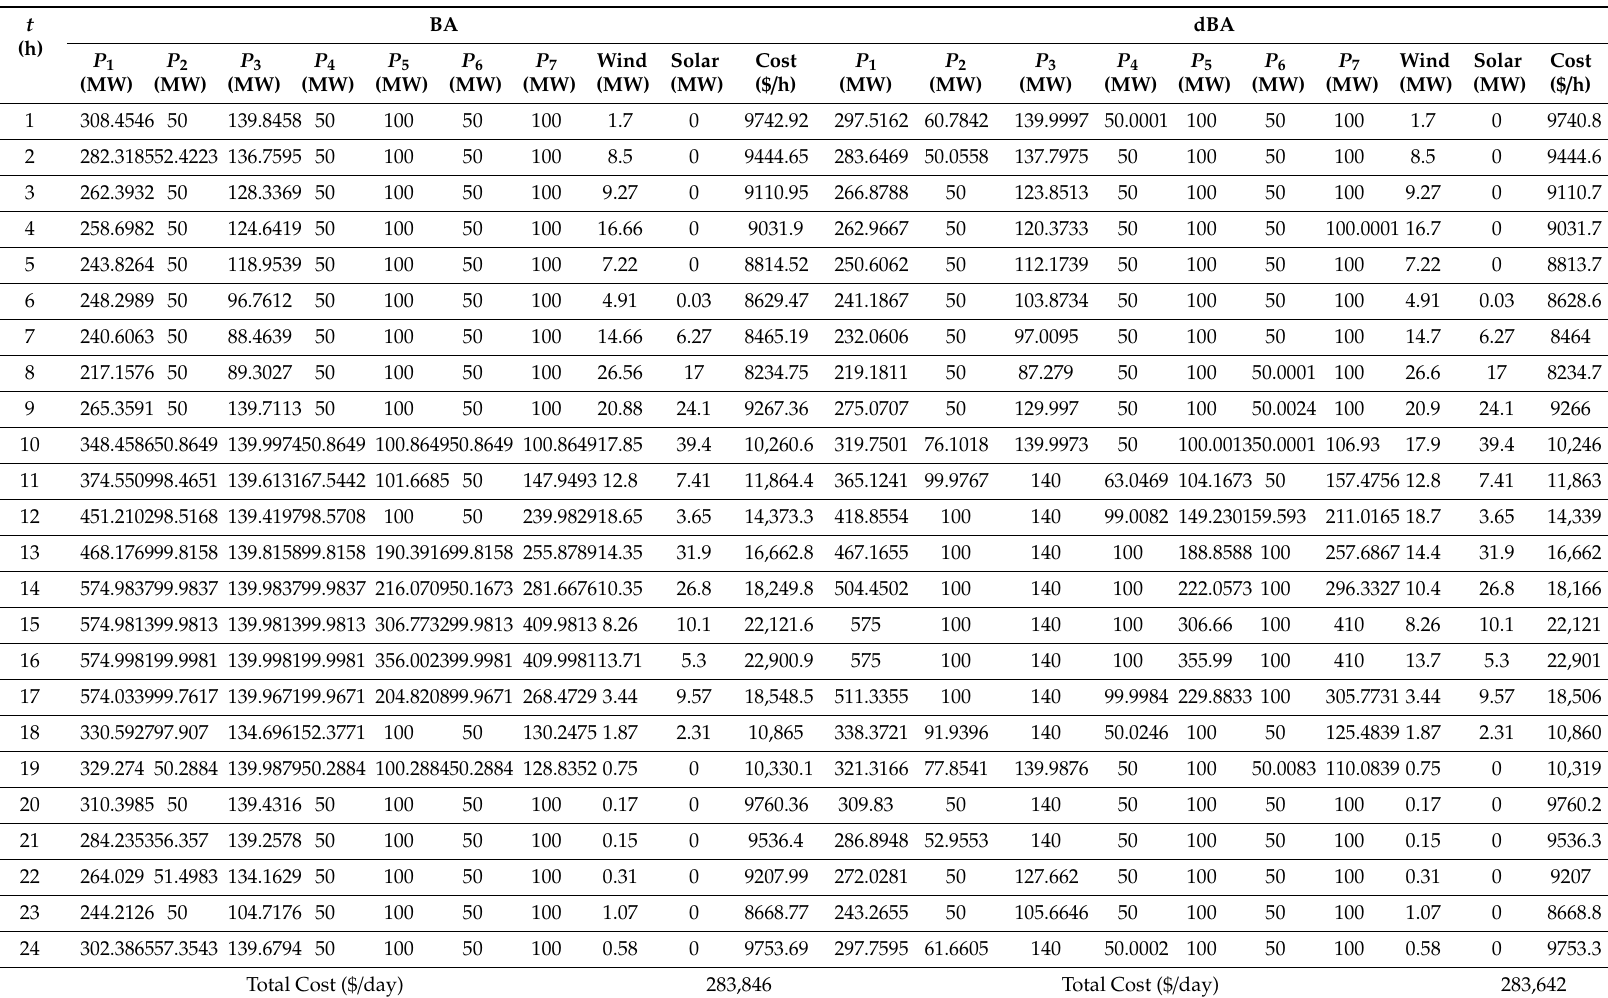
Table 4. BA and dBA on a seven-thermal unit system with renewables (wind and